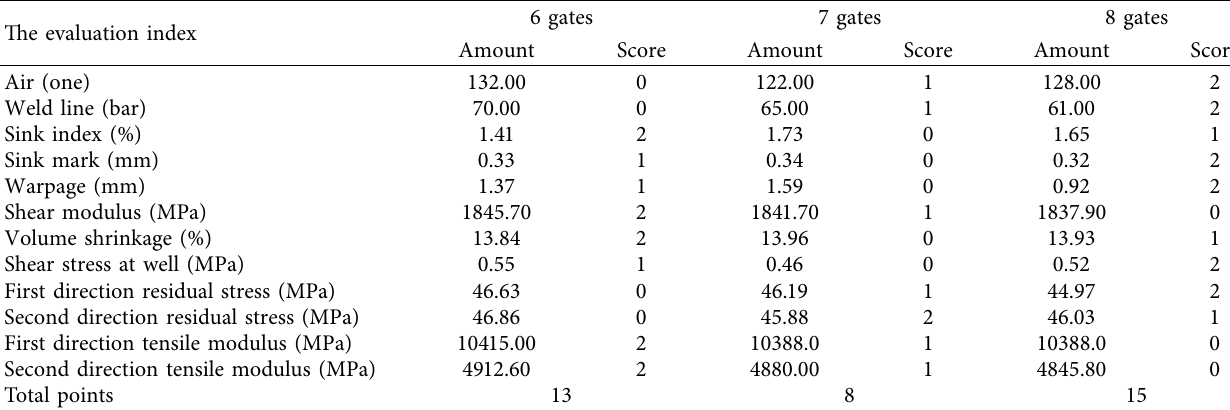
Figure 10: Volume shrinkage and warpage analysis results of the 8 gate gating systems. Table 2: The gating system comprehensive rating